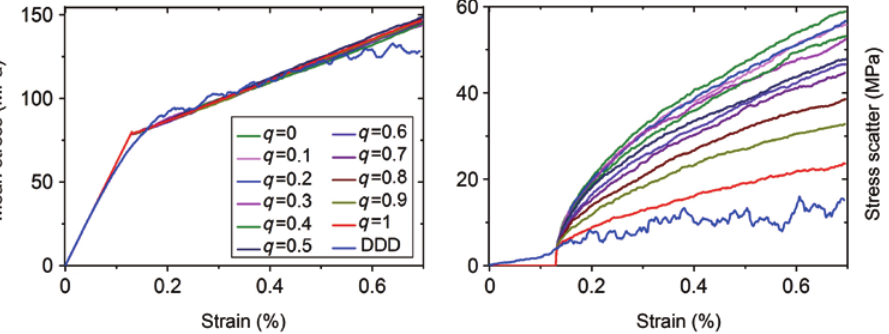
Figure 10: Left, average stress of DDD simulations (blue line) and correlated stochastic simulations (colored lines according to the correla- tion factor). Right, stress standard deviation of DDD simulations (blue line) and correlated stochastic simulations (colored lines according to the correlation